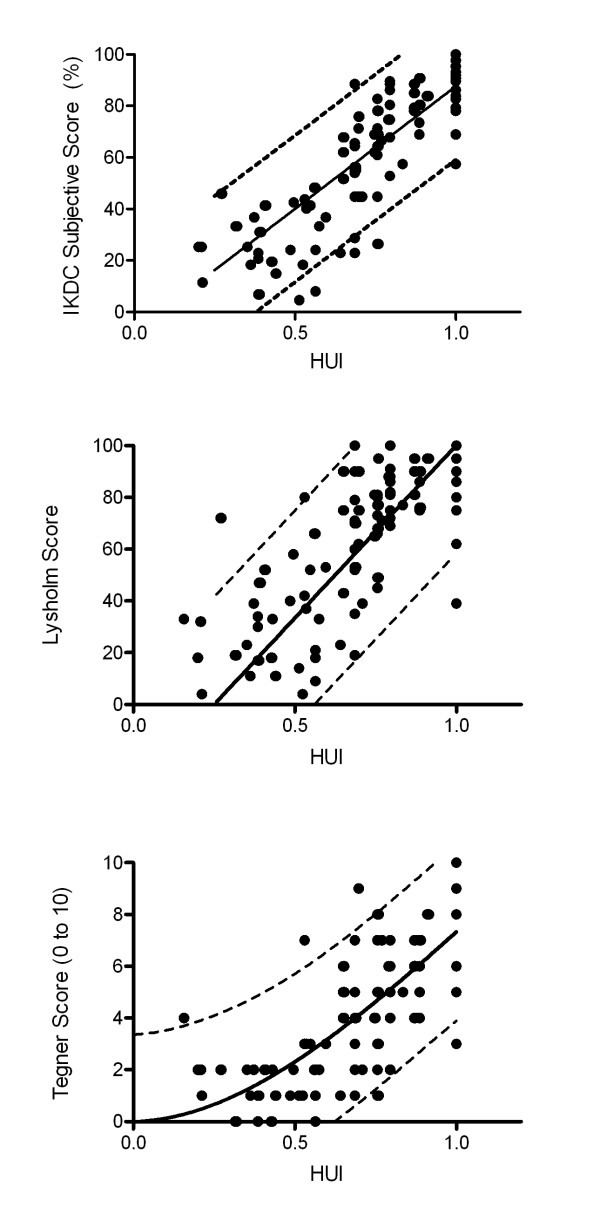
The correlation of ACL scores to the utility values. All scores correlated significantly with the utility values (p < 0.05), however, the correlation was strongest for the IKDC subjective knee score (r = 0.86, 95% CI: 0.81, 0.90). Either linear regression (A and B) or third order polynomial non-linear regression (C) was used to find a curve representing most reasonably the trend of the correlations.